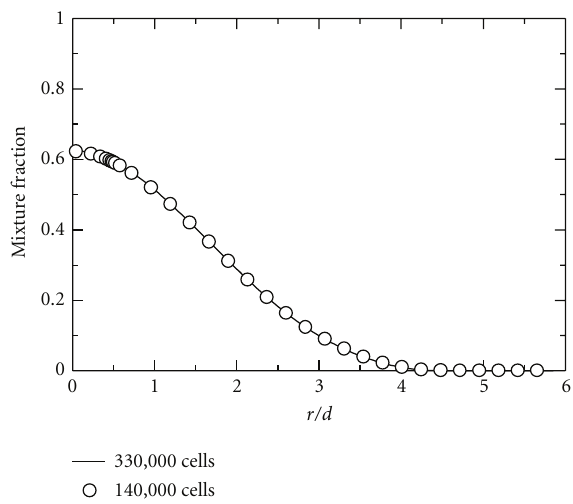
Figure 6: Radial mixture fractions predicted with di ff erent grids at x/d =